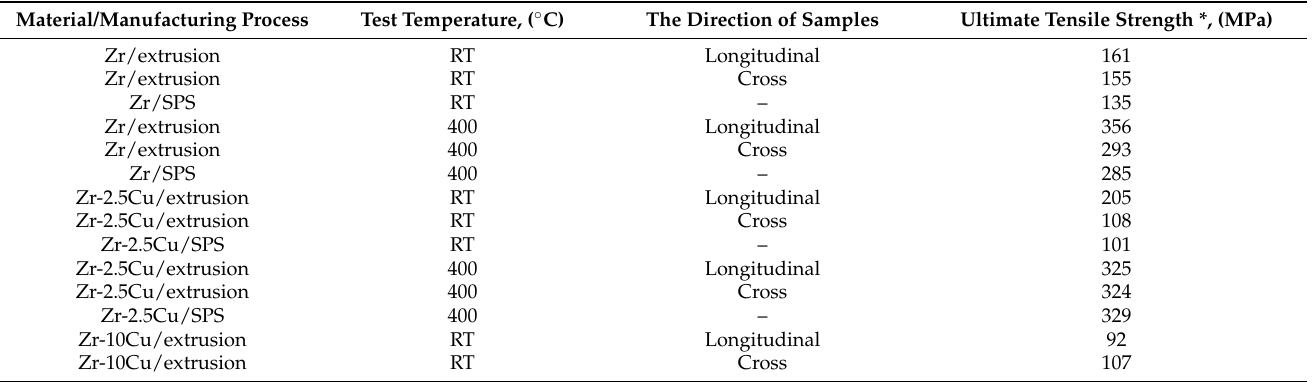
Table 4. Ultimate tensile strengths and other mechanical parameters for extruded and sintered Zr-xCu materials.